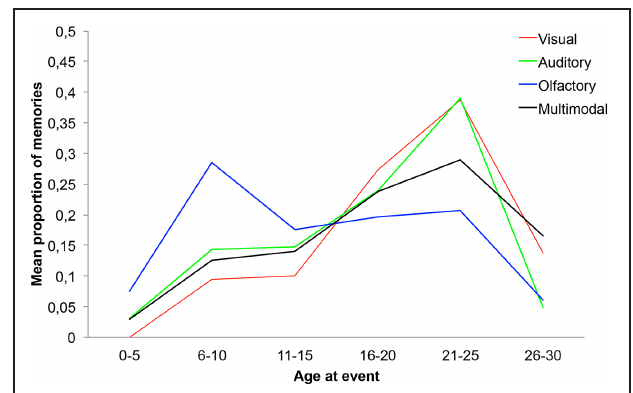
FIGURE 1 | The age distributions of the four